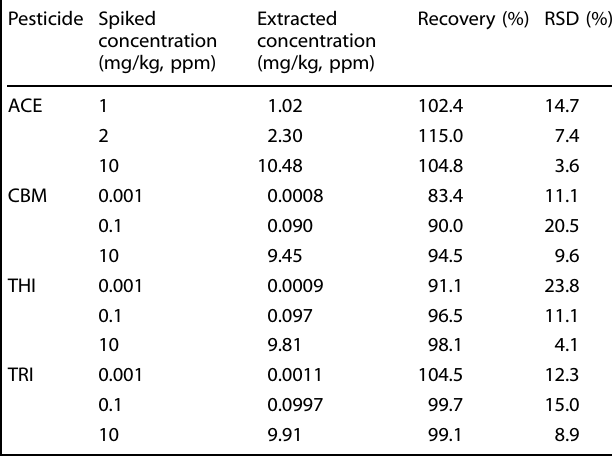
Table 1. Recovery and validation of extracted pesticide residues from basmati rice using QuEChERs